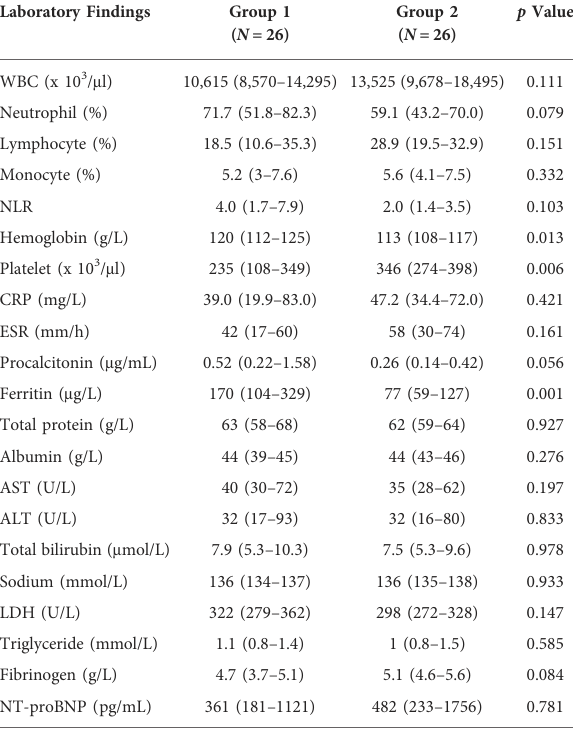
TABLE 2 Comparison of laboratory fi ndings of the two groups on the fi rst day of